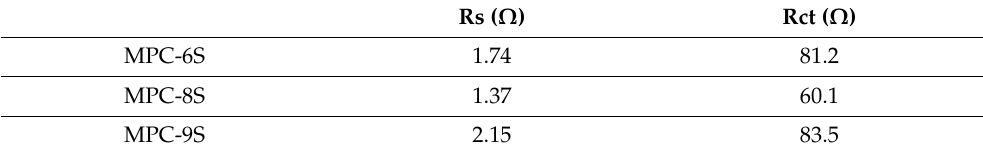
Figure 6. EIS results and equivalent circuit model of the MPC-6S, MPC-8S, and MPC-9S cells after 100 cycles. Table 2. Values of Rs and Rct for the MPC-6S, MPC-8S, and MPC-9S cells after 100